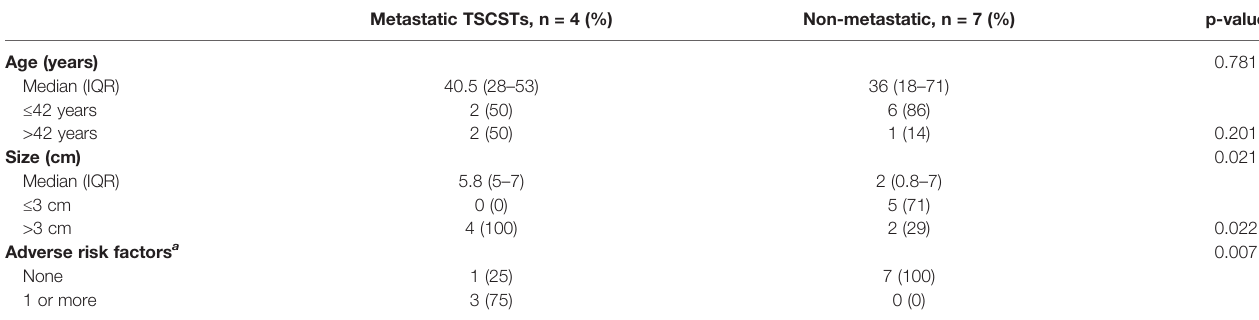
TABLE 2 | Clinical and pathological features of metastatic and non-metastatic TSCSTs.